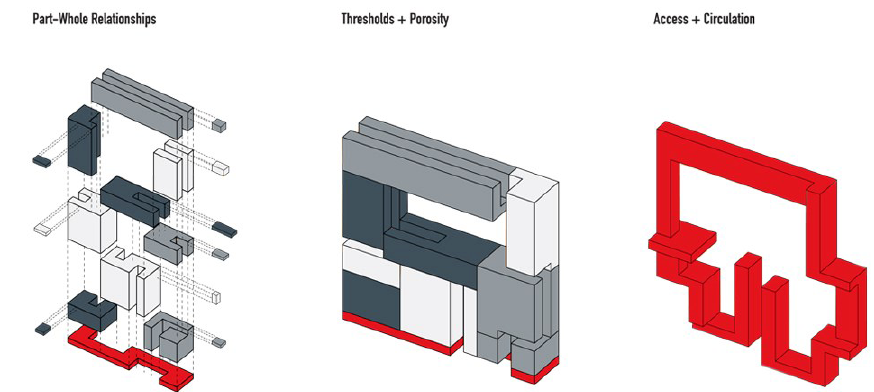
Figure 10. The Mirador urban organs packed together into one LUD. Source: MVRDV (n.d). ent tile materials and hues (Figure 10). Unlike VM House,